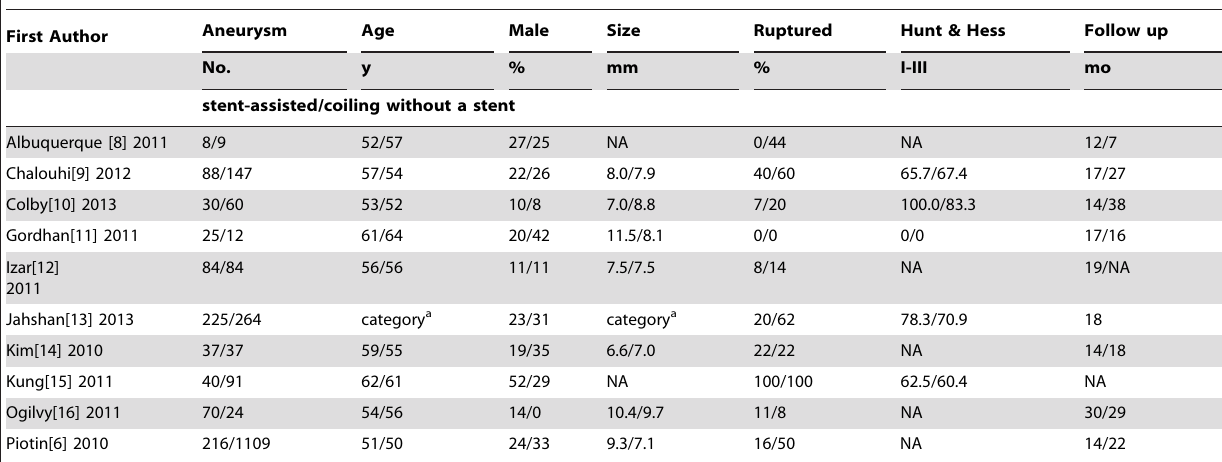
Table 1. Design and baseline characteristics of included